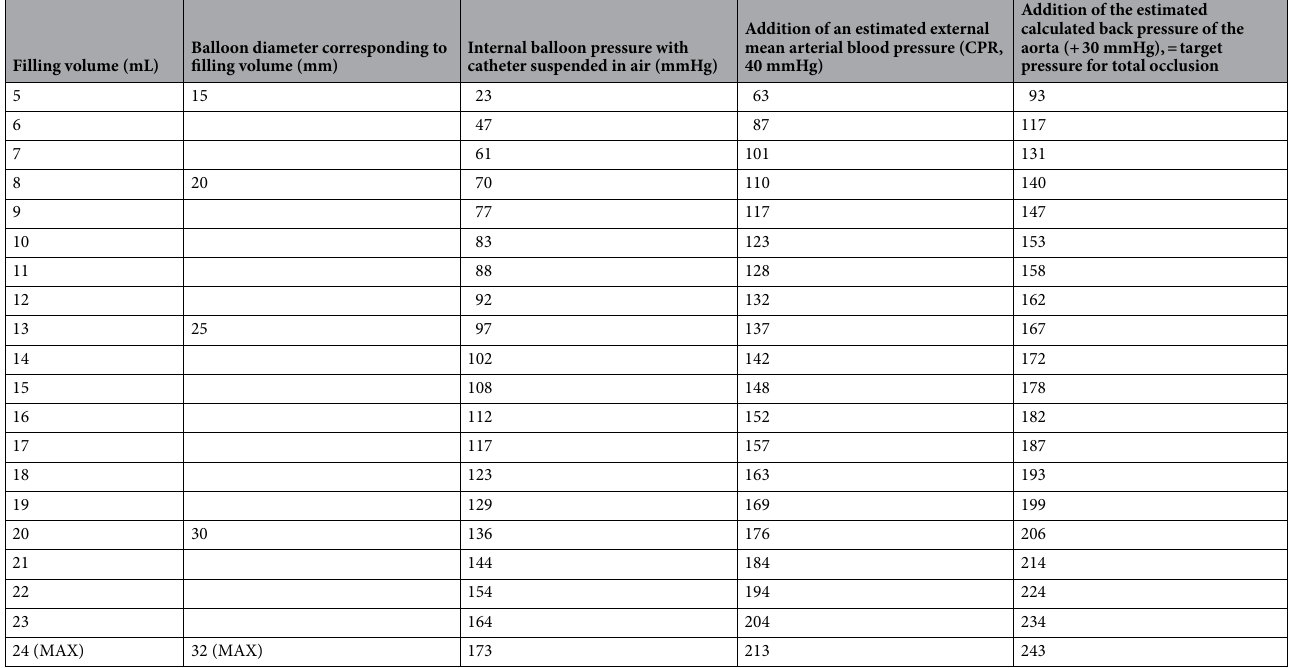
Table 1. Derivation of the “rule of thumb”. Columns 1, 2, and 3 show the balloon filling volume, resulting balloon diameter, and the resulting internal pressures when the balloon is suspended in the air and no external pressurized fluid/blood and no back pressure increase the internal balloon pressure. In column 4, we added a hypothetical mean arterial pressure of 40 mmHg, as would be generated by CPR, as the surrounding external pressure. In the 5th column, we added the calculated back pressure of the vessel at full aortic occlusion (+ 30 mmHg). Filling the balloon up to an internal pressure of 160 mmHg during CPR (or another low flow/